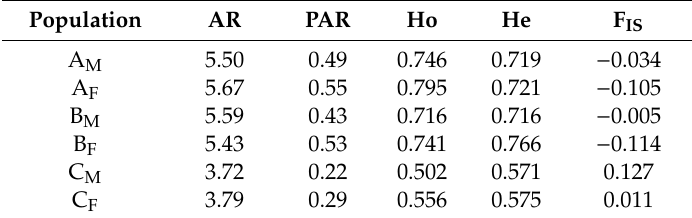
Table 6. Three large Pistacia chinensis populations divided into six populations based on gender and their genetic diversity. Population AR PAR Ho He F IS A M